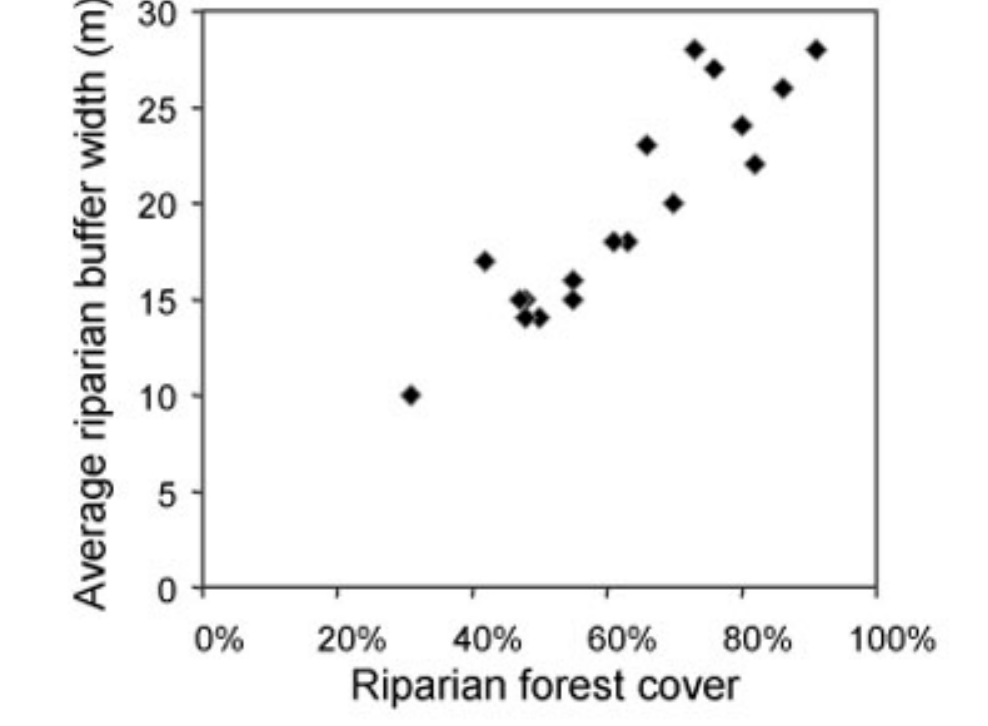
Fig. 4. Relationship between percent riparian forest cover (derived from Landsat imagery) and average forested riparian buffer widths (derived from interpretation of color infrared aerial photography) (r 2 = 0.83, n =18, p <